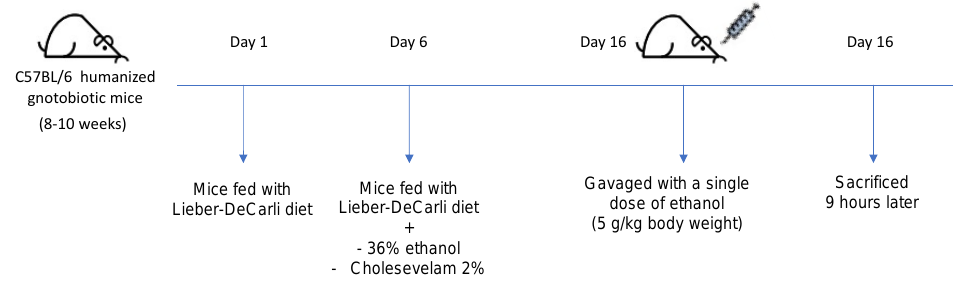
Figure 1. Experimental design.